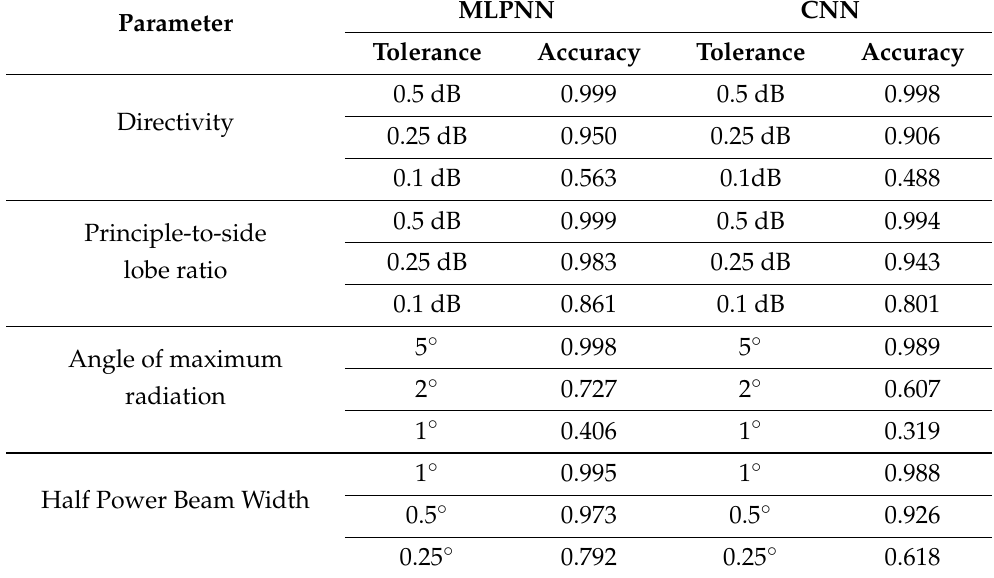
Table 5. Accuracy Measure: MLPNN vs